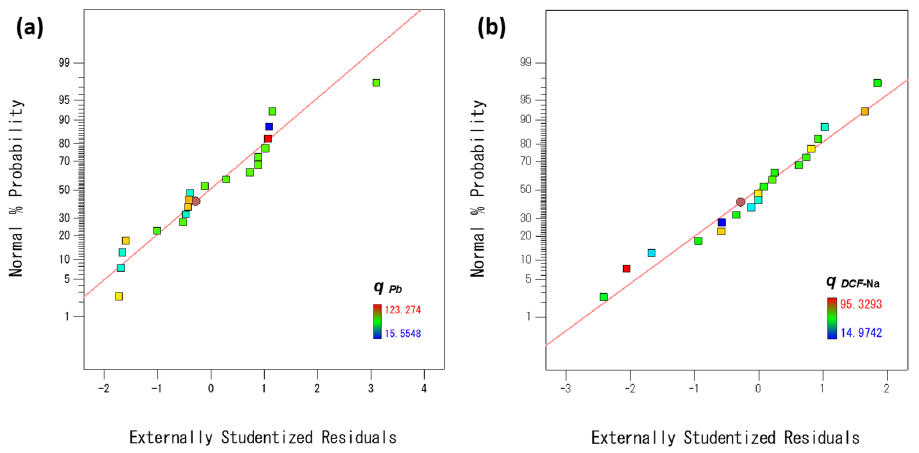
Figure 5. Normal plots of residuals for ( a ) q Pb and ( b ) q DCF ‐ Na.